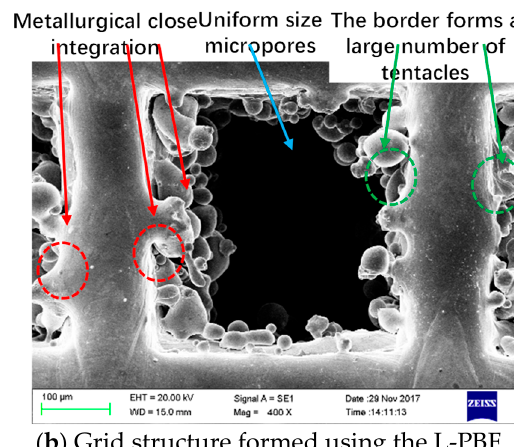
Figure 11. SEM images of the microporous grid structures.